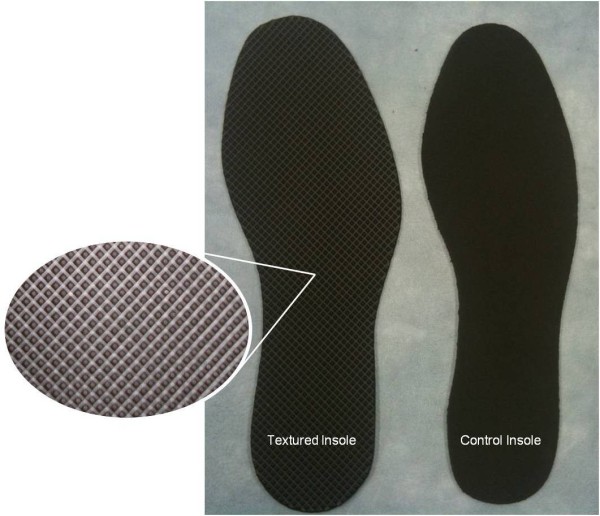
Textured and control insoles.